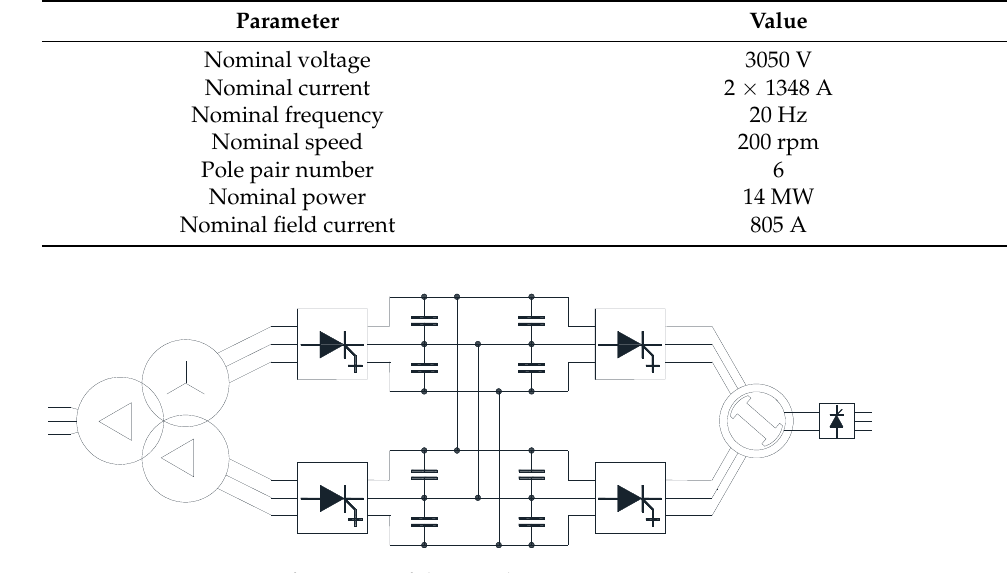
( b ) Figure 9. ( a ) comparison of obtained d -axis magnetization curve with that from a test report; ( b ) obtained q -axis magnetization curve. 0